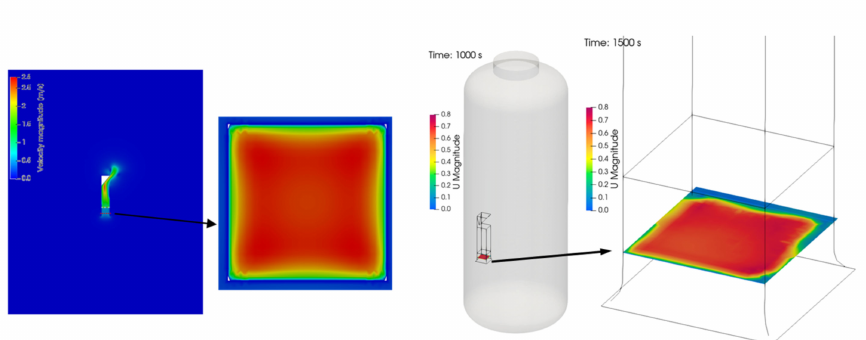
Figure 7. Profile of a PAR inlet velocity according to